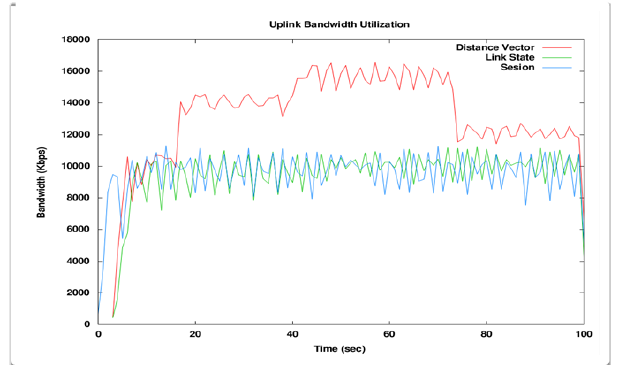
Figure 3: Bandwidth Utilization for Distance Vector, Link State and Session Routing Protocol